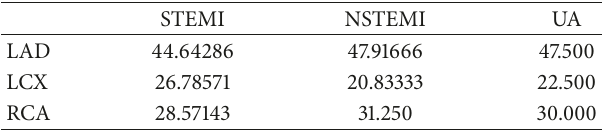
Table 2: Showing distribution of angiographic pattern in all the groups.